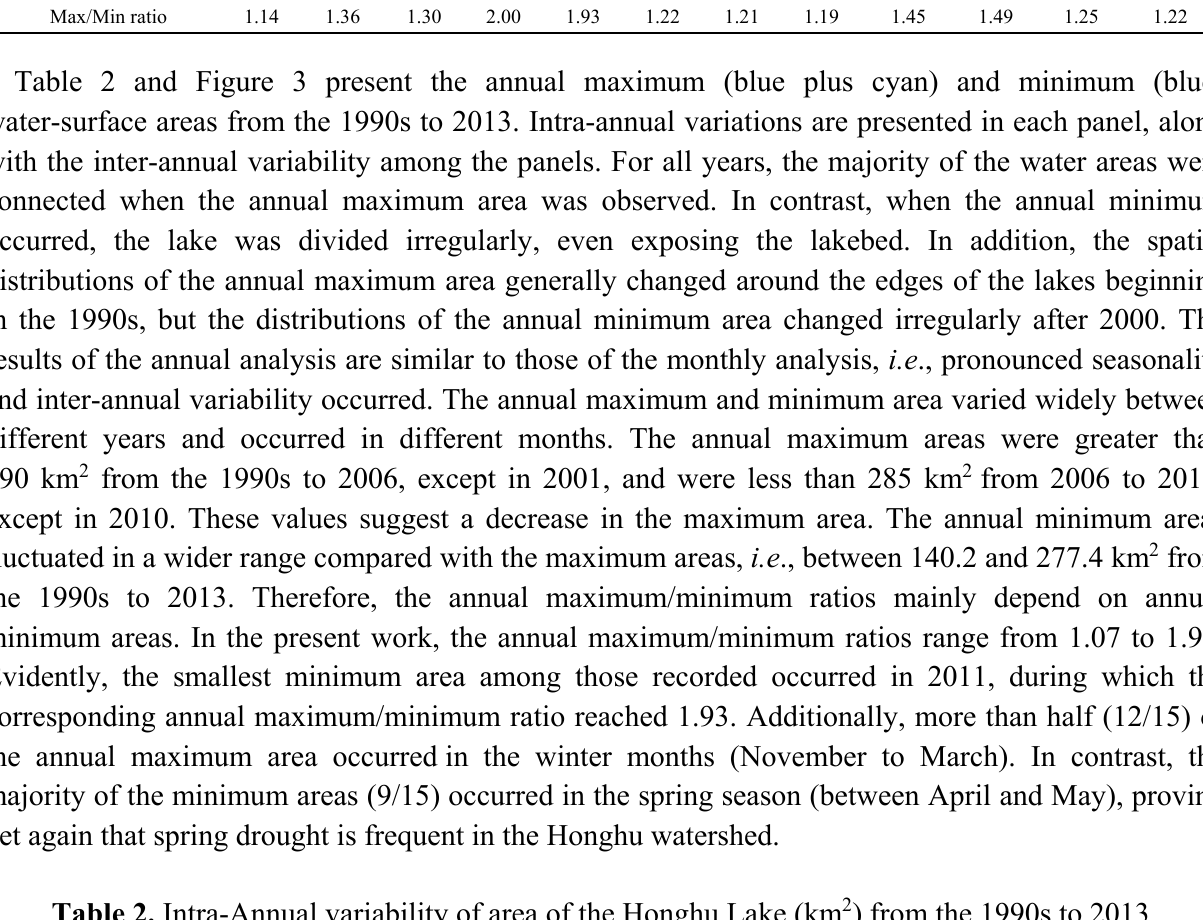
Table 2. Intra-Annual variability of area of the Honghu Lake (km 2 ) from the 1990s to